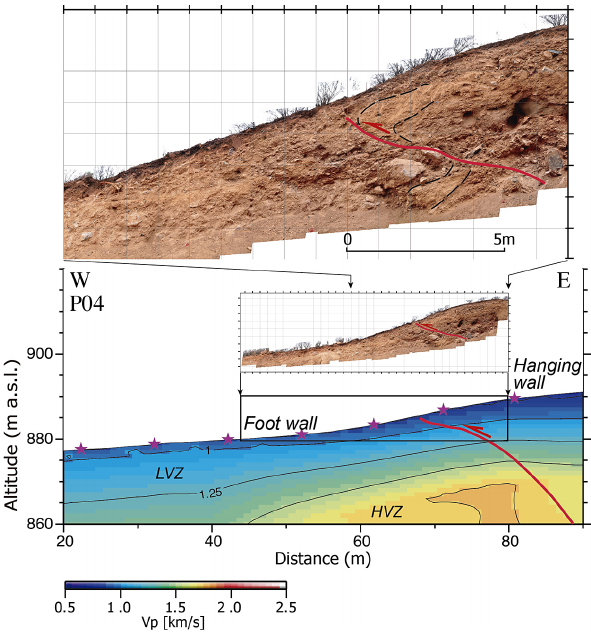
Figure 11. Surface observation of a fault affecting recent sediments close to seismic profile P04, from ongoing paleoseismological stud- ies (Vargas and Rebolledo, 2012), together with a zoomed view of the results obtained along this